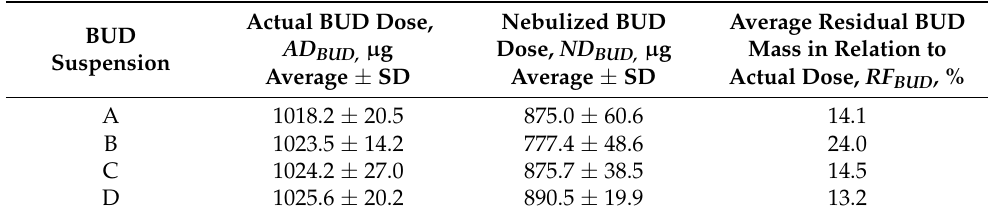
Table 7. Amounts of BUD in the inhalation products (before and after nebulization) and calculated mean residual amounts. The nominal (label) BUD dose in all formulations was 1000.0 µ g.